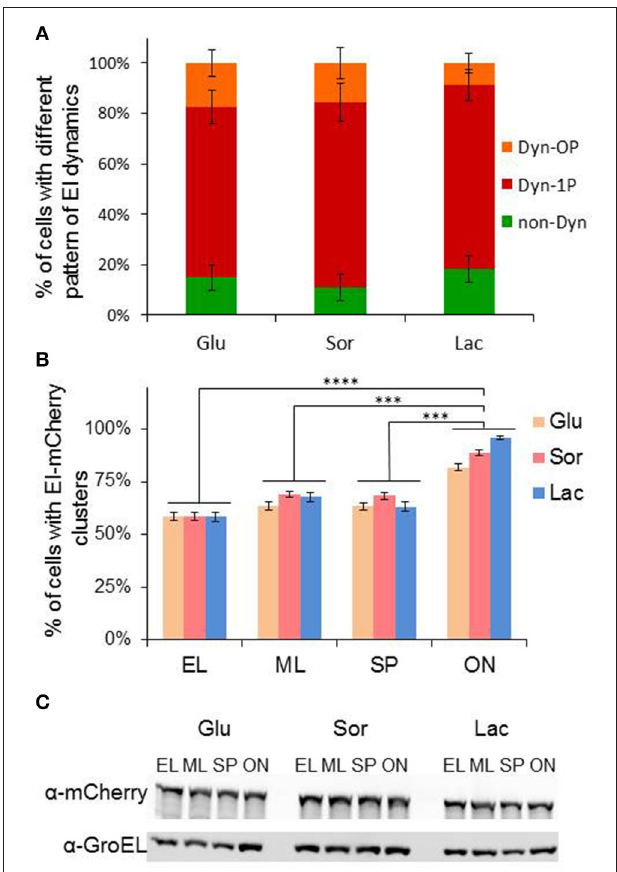
FIGURE 4 | Growth phase, but not the carbon source in the growth medium, affects formation of EI clusters . (A) Stacked column chart showing the fractions of cells that exhibit a certain pattern of EI dynamics, i.e., non-dynamic (non-Dyn, green), dynamic within one pole (Dyn-1P, red) and dynamic from pole to midcell or from pole to pole (Dyn-OP, orange), in populations grown to early logarithmic phase in minimal medium supplemented with glucose (Glu, n = 328), sorbitol (Sor, n = 311) or lactose (Lac, n = 286). Cells from three independent experiments were analyzed. Ordinary one-way ANOVA indicated no significant variations among the samples. (B) Column chart of the fraction of cells with detectable clusters in cultures grown on different carbon sources glucose (Glu), sorbitol (Sor) or lactose (Lac) at different growth phases: early log (EL; OD 600 0.2–0.25), mid-log (ML; OD 600 0.5–0.55), early stationary phase (SP; OD 600 1.00–1.1) and after overnight growth (ON). More than 400 cells were analyzed from three independent experiments. P -values were obtained by ordinary one-way ANOVA: *** p -value < 0.001; **** p -value < 0.0001. (C) Western blot analysis showing the level of EI-mCherry and GroEL proteins, detected by α -mCherry and α -GroEL antibodies, respectively. Cells were grown on different carbon sources to different growth phases, as in (B) . Equal amount of samples were collected at specific growth phases, separated on 10% SDS polyacrylamide gel, blotted onto nitrocellulose membrane and detected by the two